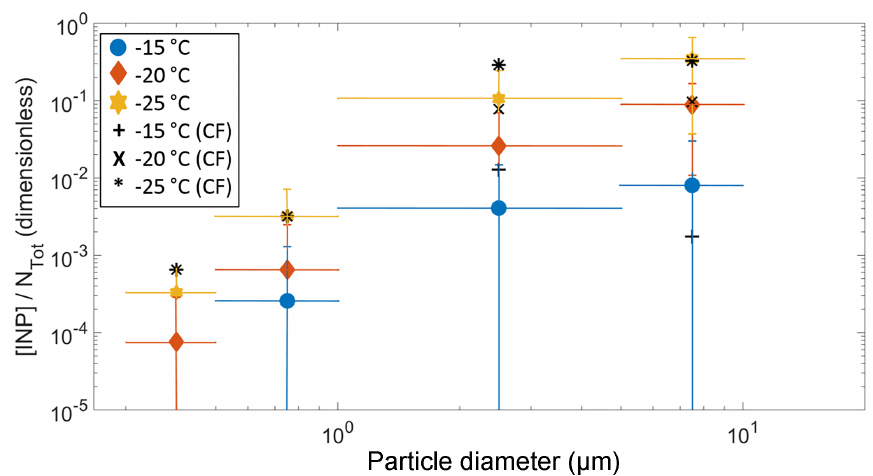
Figure 7. The fraction of aerosol particles acting as an INP ([INP]/ N Tot ) as a function of particle size at − 15, − 20, and − 25 ◦ C. N Tot refers to the number of aerosol particles in a given size range measured by the LasAir. The solid colored symbols represent the entire campaign, while the black symbols represent the samples collected under the influence of the cold fronts.